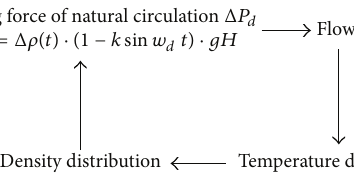
𝑇 = 3 s and 𝑘 = 0.2, 0.4, 0.6 , respectively. Results indicated the